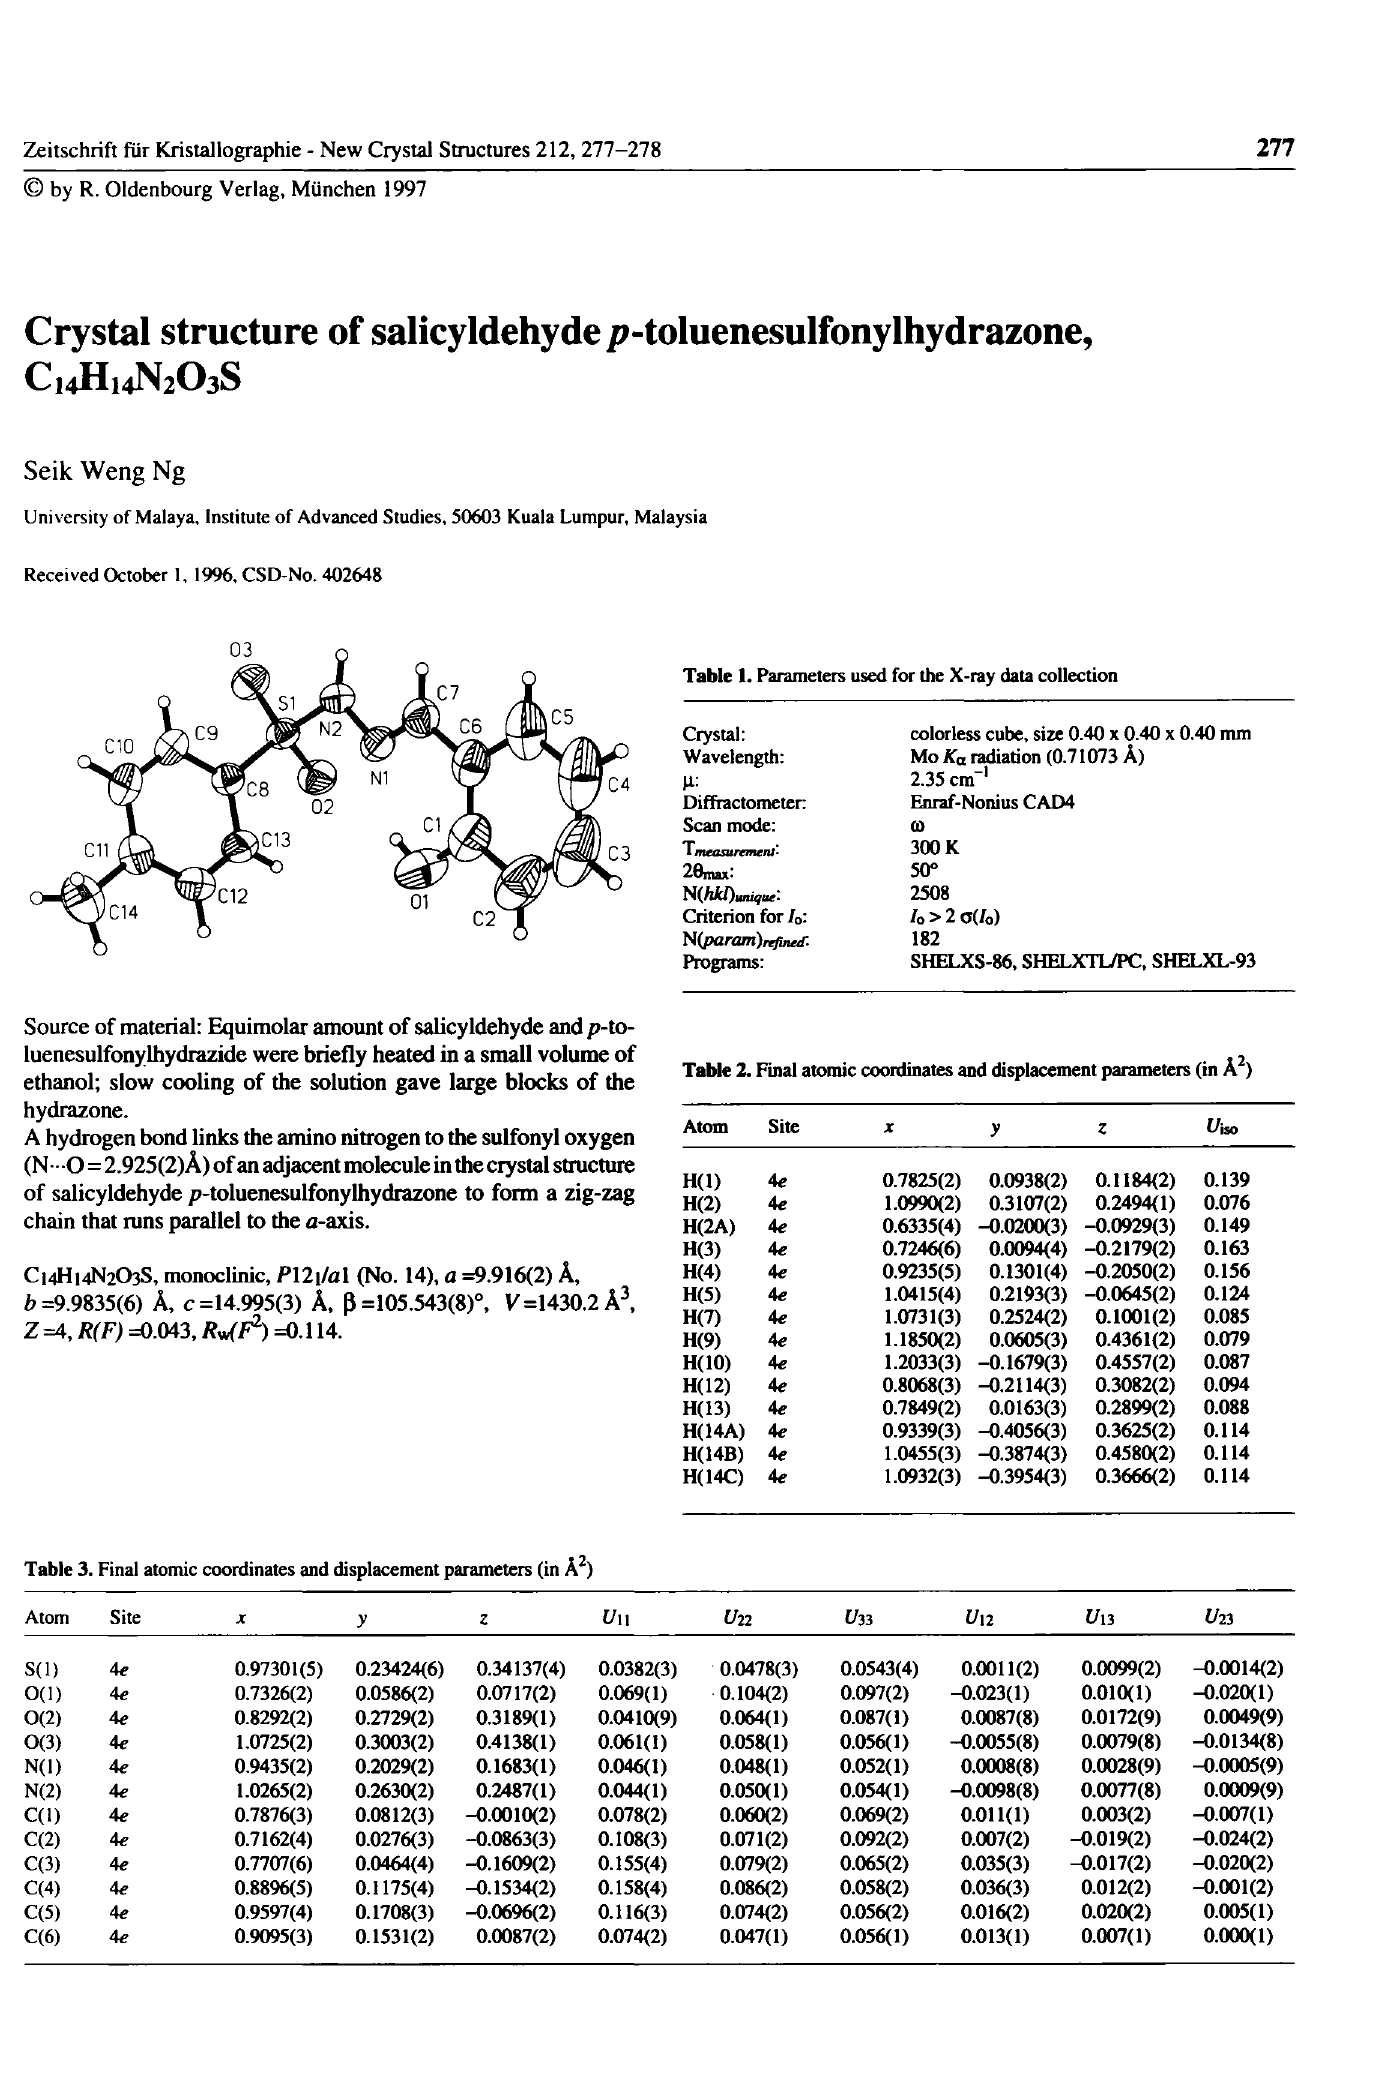
Table 3. Final atomic coordinates and displacement parameters (in Ä 2